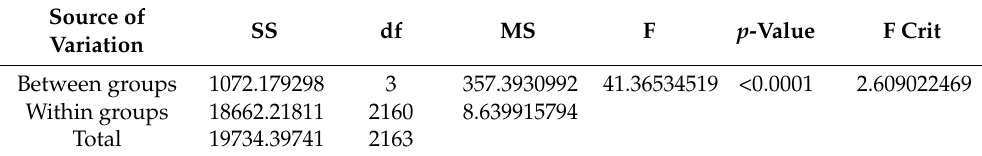
Table 3. Summary of ANOVA results for simulated occupancy for four typical teaching and learning activities in the same room, without contact time